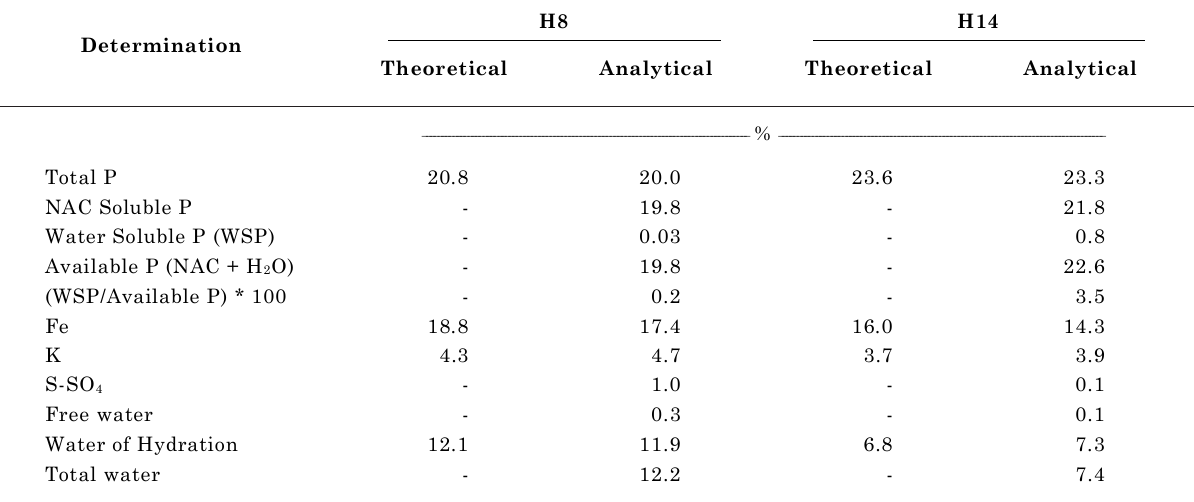
Table 1. Elemental chemical composition – theoretical and obtained by analytical methods – for the compounds H8 and